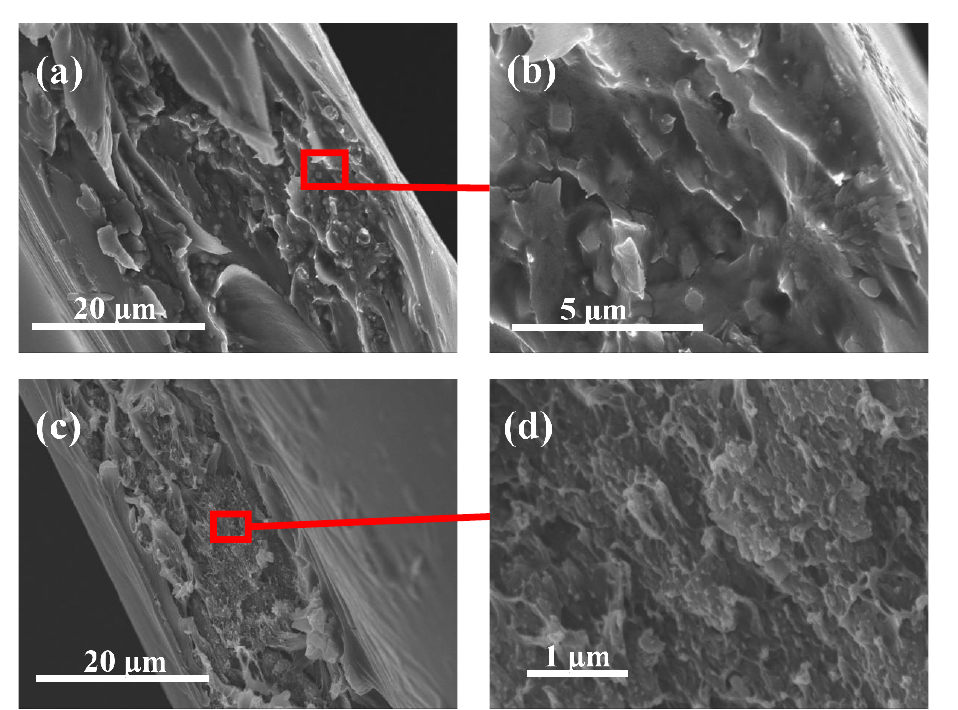
Figure 3. Cross-section SEM images of MMM with AP loading: ( a,b ) 5AP/ FDA-Durene and amplification; and ( c,d ) 10AP/ FDA-Durene and amplification.